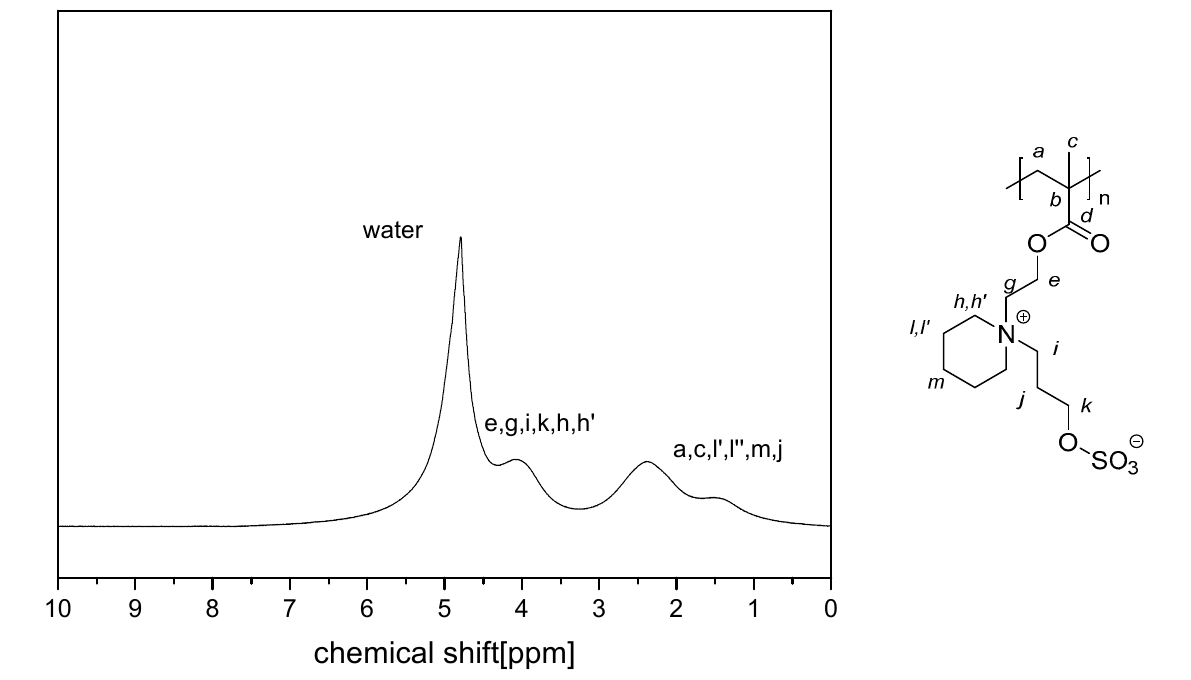
Figure A16. 1 H NMR-spectrum of polymer P − 4d in D 2 O saturated with NaCl.